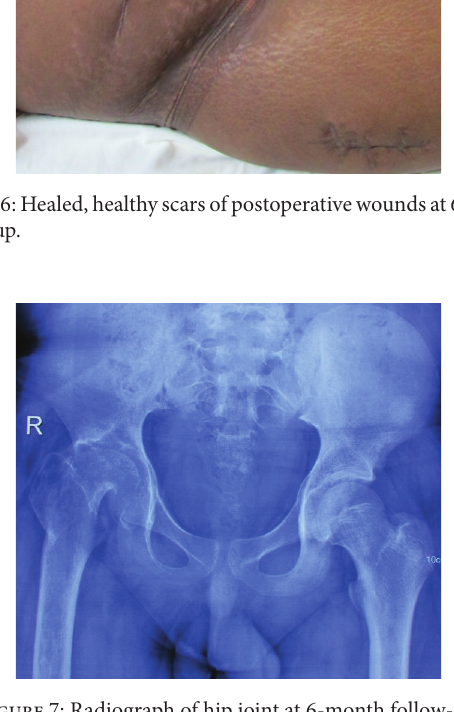
Figure 7: Radiograph of hip joint at 6-month